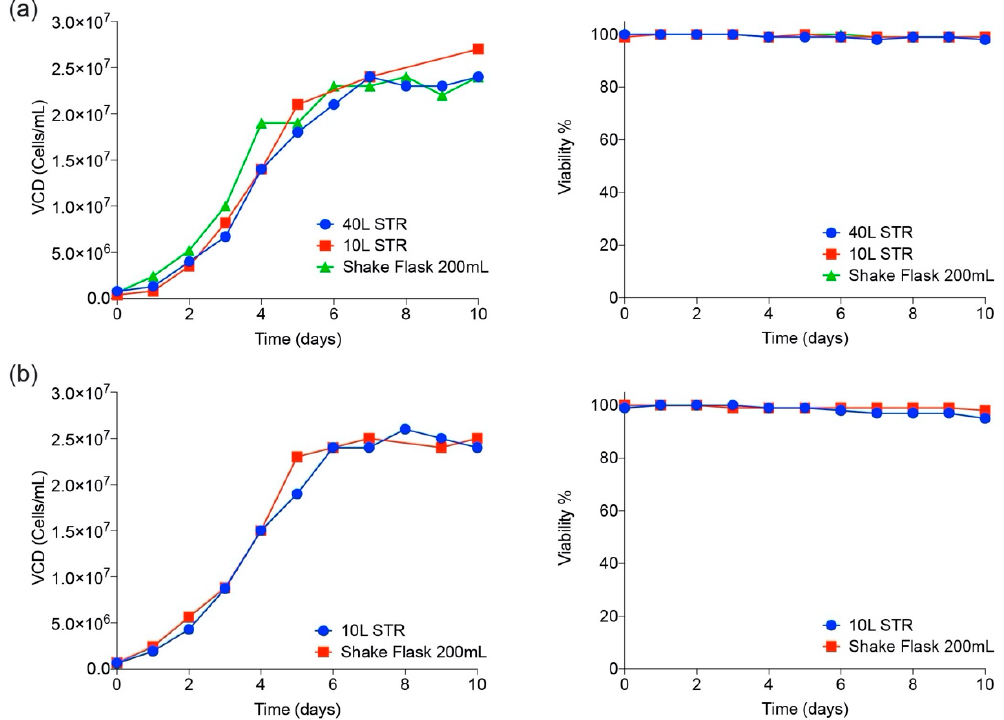
Figure 2. Cell culture scale-up performance in shake flasks and bioreactors. Viable cell densities (cells/mL) and viability (%) are shown at various scales of operation for both trimeric spike ( a ) and RBD ( b ).